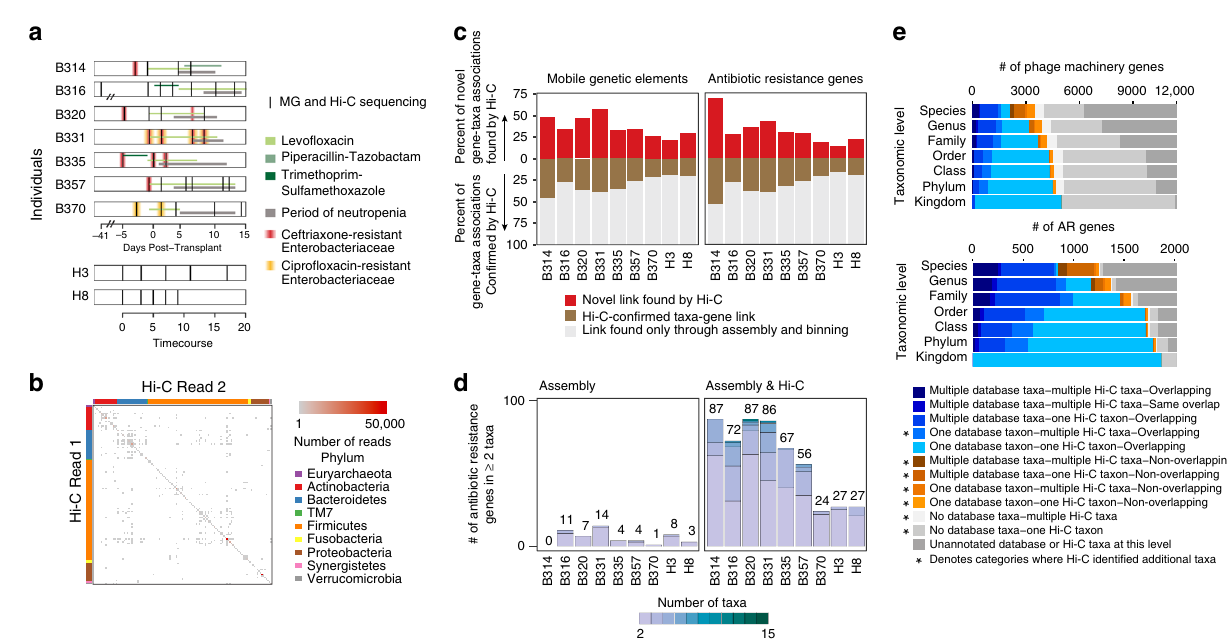
Fig. 1 Hi-C can be used to track mobile genetic elements. a Neutropenic hematopoetic stem cell transplant (B) recipients ’ and healthy (H) individuals ’ timecourses included in the study are depicted, with periods of neutropenia (gray) and antibiotic use (green). Black lines indicate timepoints for which metagenomic and Hi-C libraries were constructed. Red lines indicate gastrointestinal colonization with MDR enteric pathogens. b Each Hi-C read pair that maps to two non-mobile contigs is plotted according to the taxonomic assignment of each read. Color depicts the number of reads linking contigs according to taxonomy. c The percent of the total taxa-mobile gene (left) and taxa – AR gene (right) associations observed from metagenomic assembly that are supported by two or more Hi-C links (brown) is plotted, along with the percent additional interactions gained by using Hi-C (red). d Stacked bar plots showing the number of species-level taxa to which each AR gene (clustered at 99% identity) is assigned within each patient, and across patients. Only those genes assigned to two or more taxa are shown. We either used metagenomic assemblies alone to assign taxonomies (left) or combined with Hi-C libraries considering those taxa-gene assignments with evidence from at least two Hi-C reads. The numbers above each stacked barplot represent the total number of AR genes with two or more taxonomic associations. e Horizontal stacked bar plots show the percentage of unique phage genes (de fi ned as 95% similar) (above) or AR genes (below) in the metagenomic assemblies and the origins of their taxonomic associations, identi fi ed either by BLAST to NCBI ’ s NT (for phage) or PATRIC ’ s reference database (for AR genes) or through Hi-C